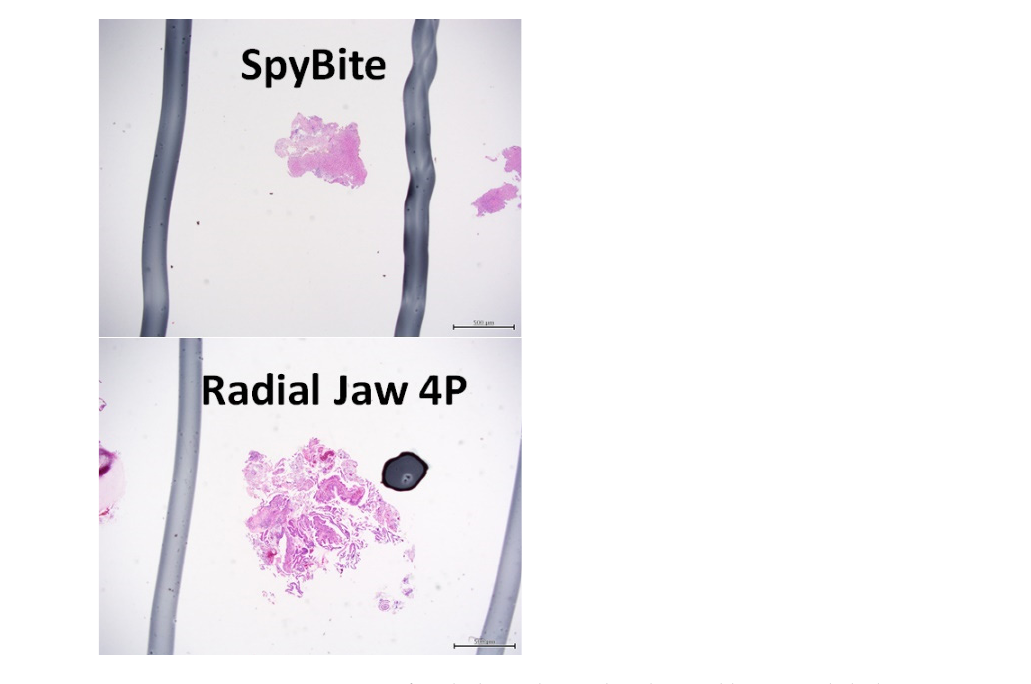
Figure 4. Microscopic images of pathological samples obtained by peroral cholangioscopy-guided and fluoroscopy-guided biopsy. Pathological samples from cholangioscopy-guided biopsies ( upper panel ) and fluoroscopy-guided biopsies ( lower panel ).